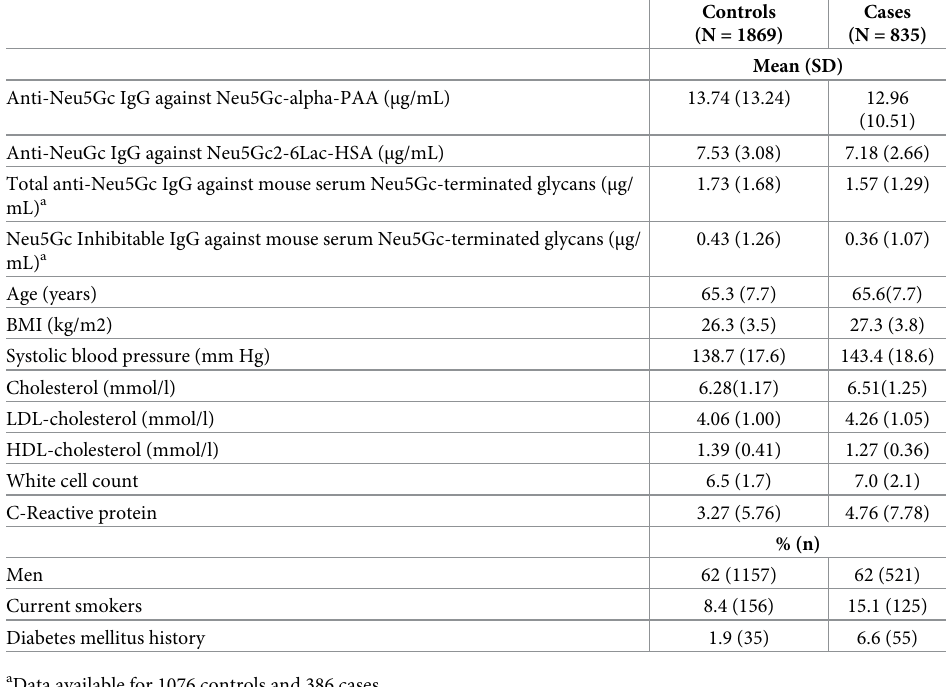
Table 2. Comparison of serum anti-Neu5Gc antibody levels between coronary artery disease cases and controls matched for age and sex in the EPIC-Norfolk